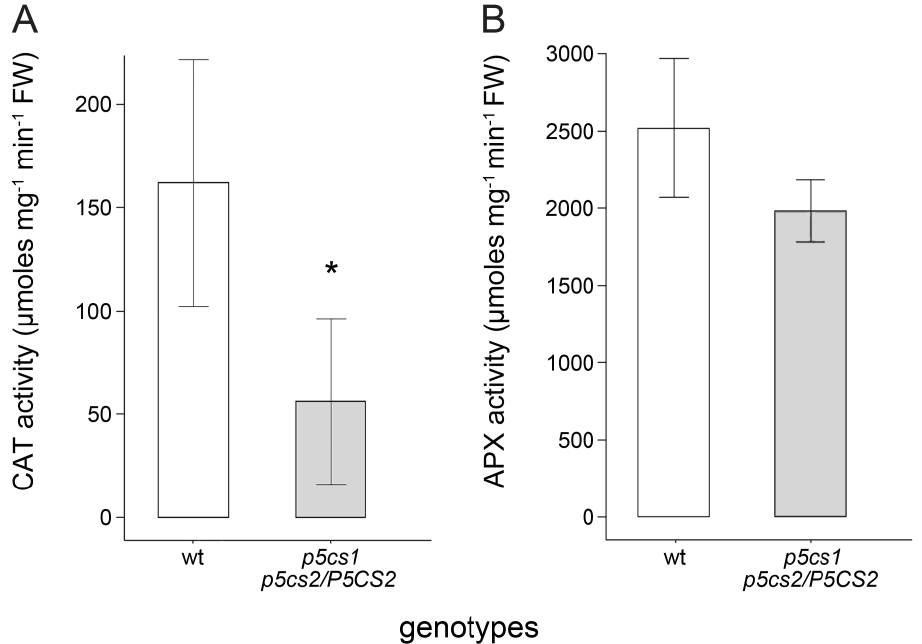
Figure 10. Enzymatic activity of catalase (CAT) and ascorbate peroxidase (APX) in wildtype and p5cs1 p5cs2/P5CS2 roots. CAT ( A ) and APX ( B ) are considered the most effective scavengers of H 2 O 2 in the plant cell. The values are the means of four independent experiments. Error bars indicate Standard Deviation (SD). The statistical significance (* p < 0.05) was calculated with a Welch test. The data represent the means ± SD of at least four independent experiments and three technical replicates per experiment.